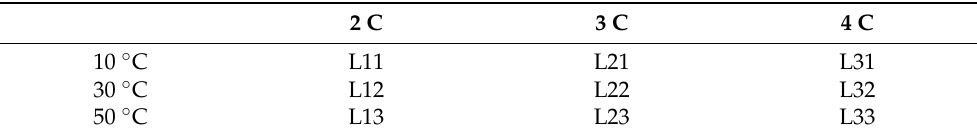
Table 1. Aging paths of the battery.